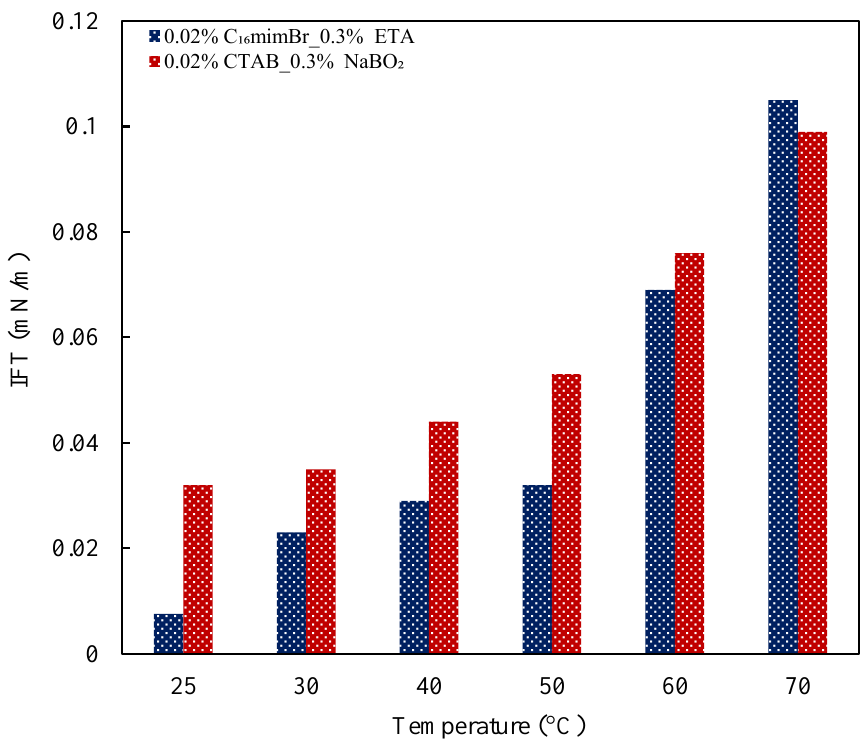
Figure 11. Effect of temperature on IFT reduction by AS formulations.